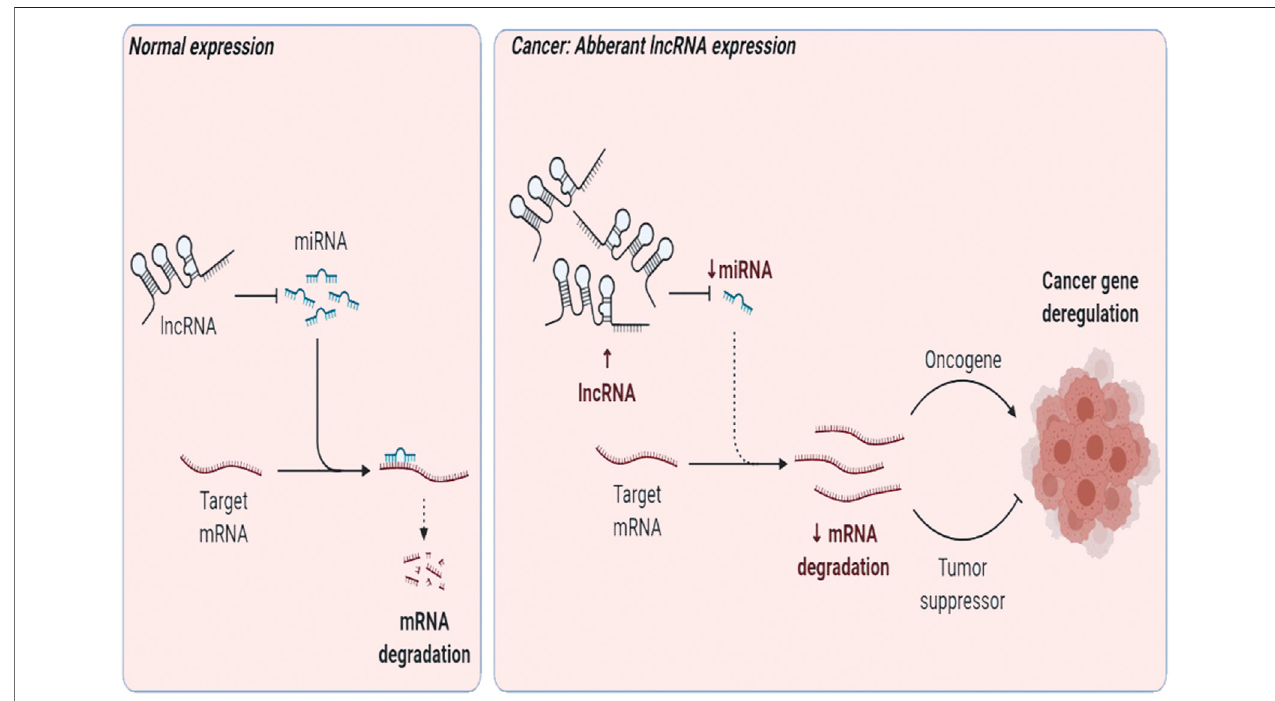
FIGURE 2 | LncRNA – miRNA gene expression regulation in normal vs. cancer phenotype.